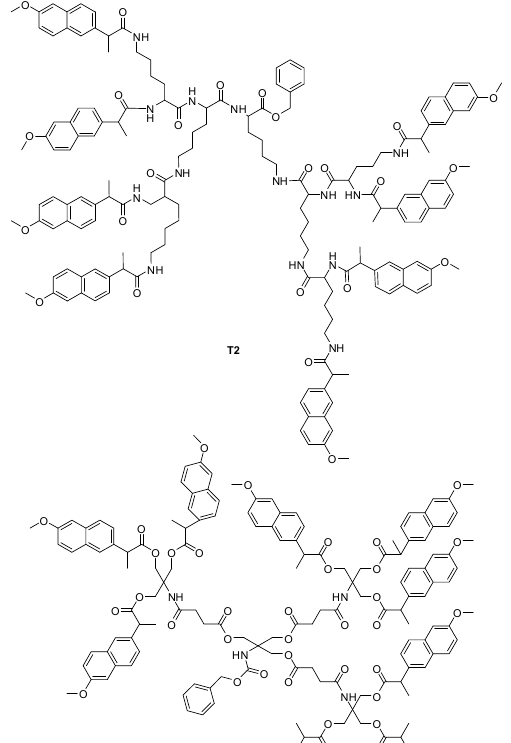
Figure 11. Dendrimer prodrugs for neglected diseases containing 3-hydroxyflavone, NFOH and quercetin [58].